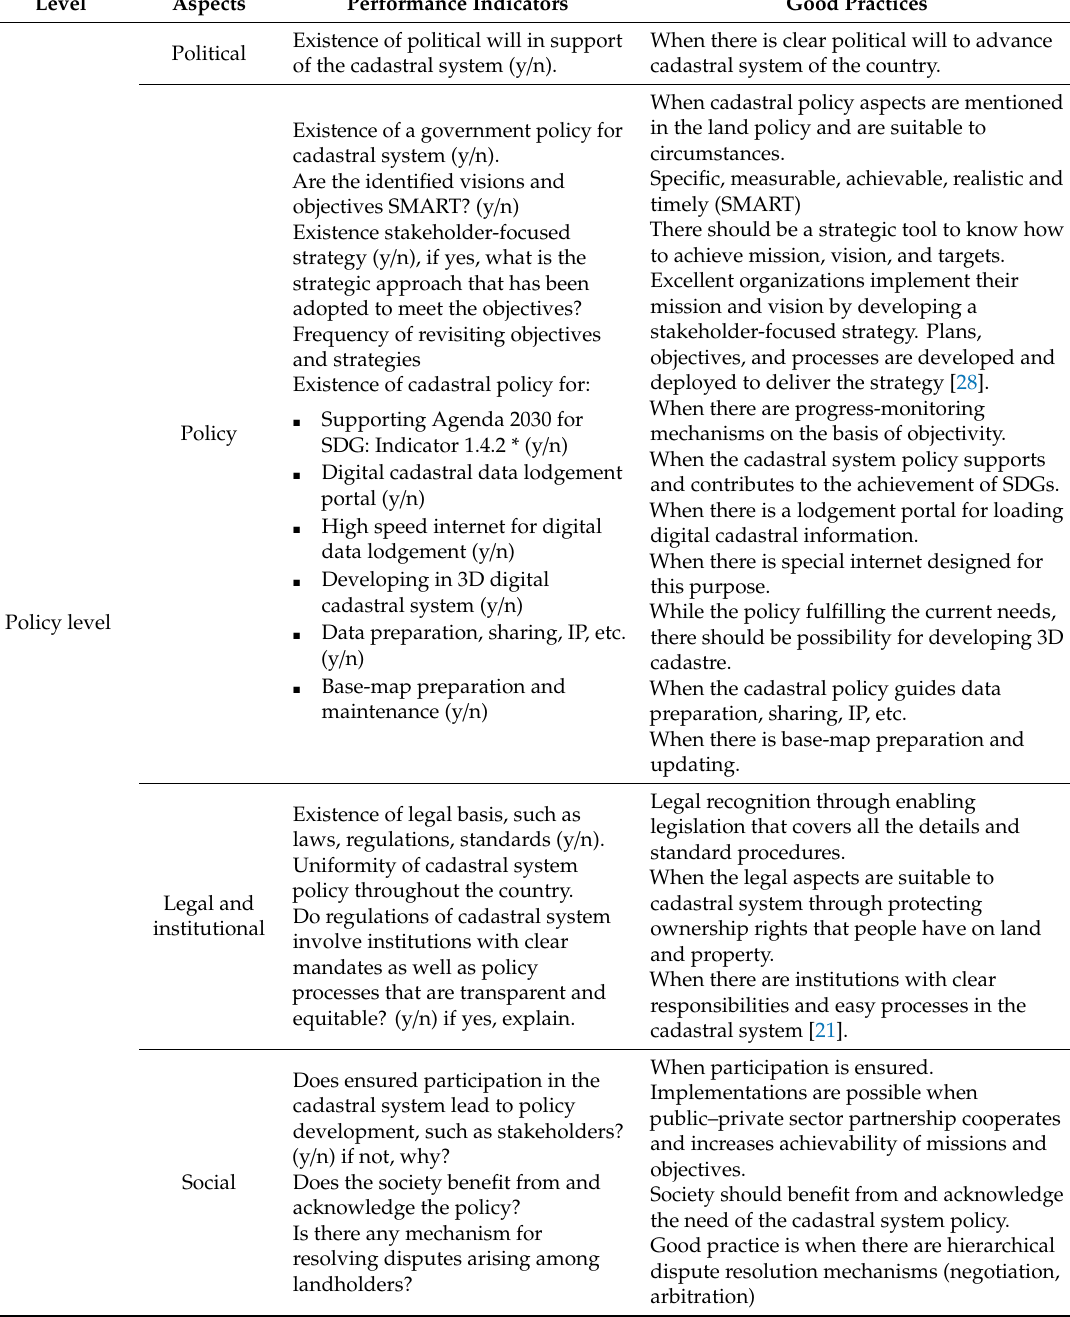
Table 2. An evaluation framework for urban cadastral